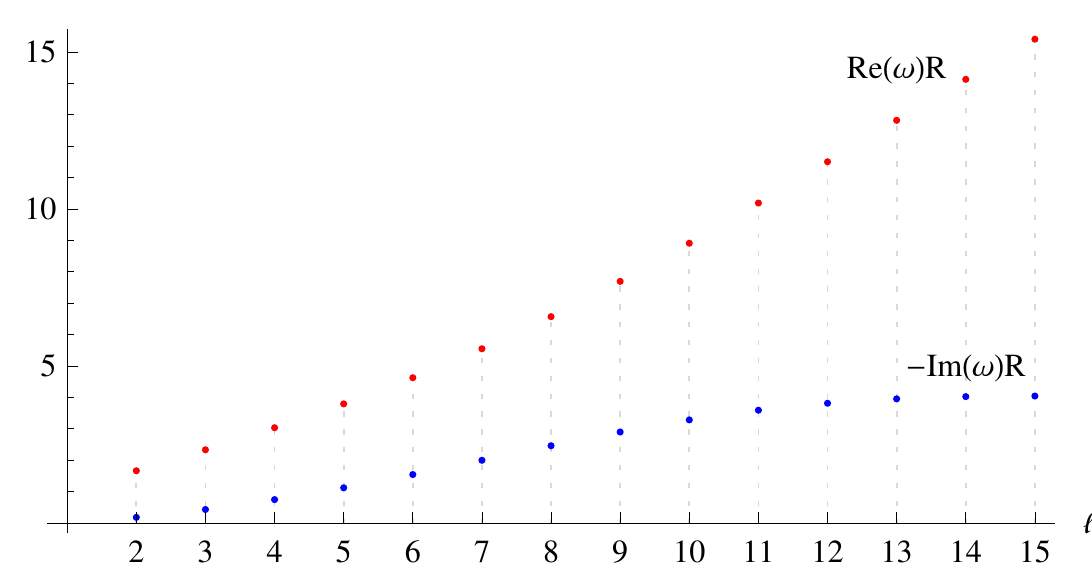
Figure 2 . Fundamental scalar (sound) quasinormal modes for various values of the multipole parameter ‘ : D = 5, (cid:11) = (cid:0) 0 : 1 R 2 , r H =R = 6.